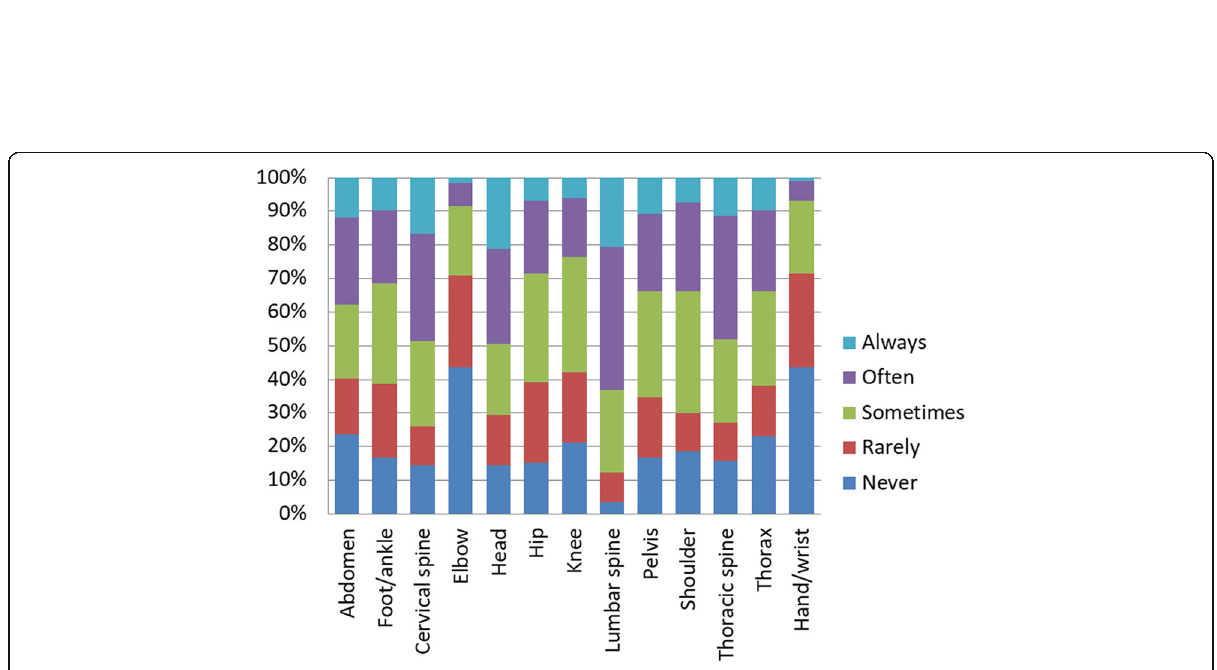
Fig. 3 «How often did you engage self-directed practice on the following body areas?» . Students had to select one answer (Always, Often, Sometimes, Rarely, Never) for each of the 13 body areas listed. The most common area approached by students was ‘ Lumbar Spine ’ . The less common area was ‘ Hand/Wrist